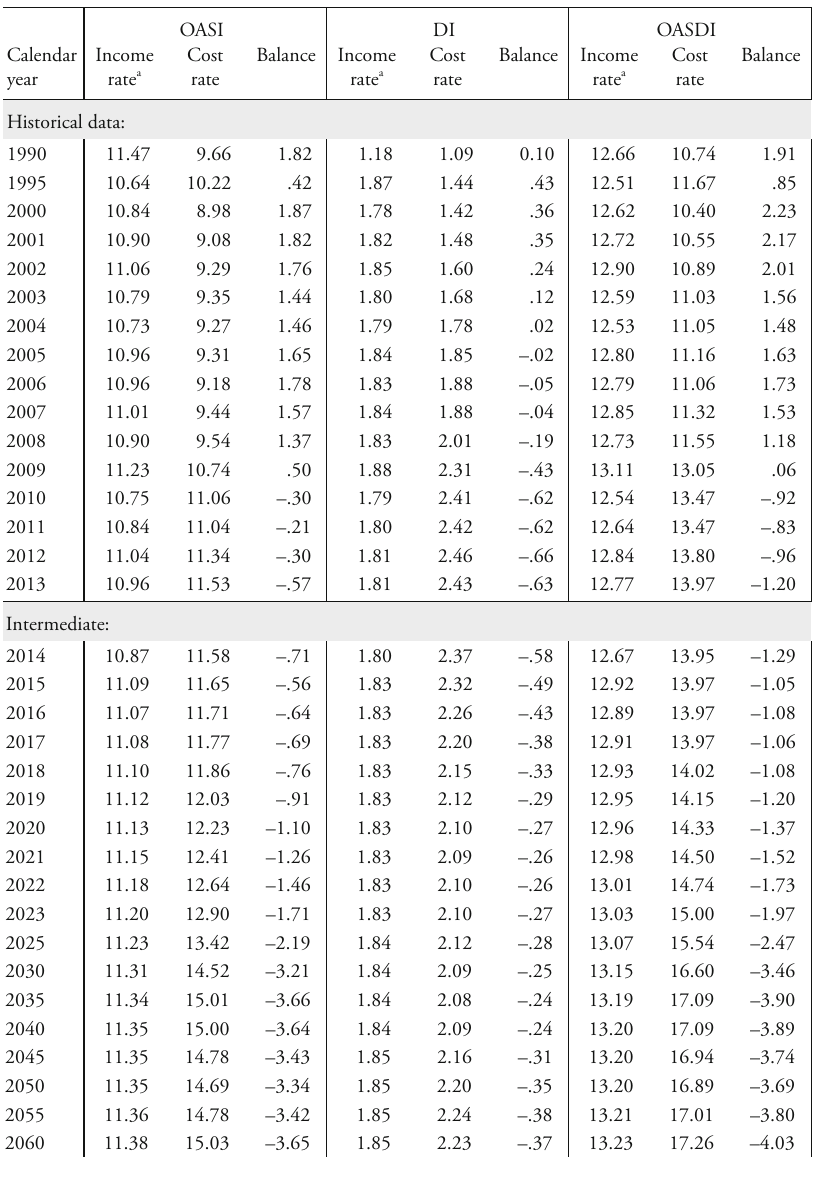
Table IV.B1: Annual Income Rates, Cost Rates, and Balances, Calendar Years 1990–2090 (as a Percentage of Taxable Payroll) OASI DI OASDI Income Cost Balance Income Cost Balance Income Cost rate a rate rate a rate rate a rate